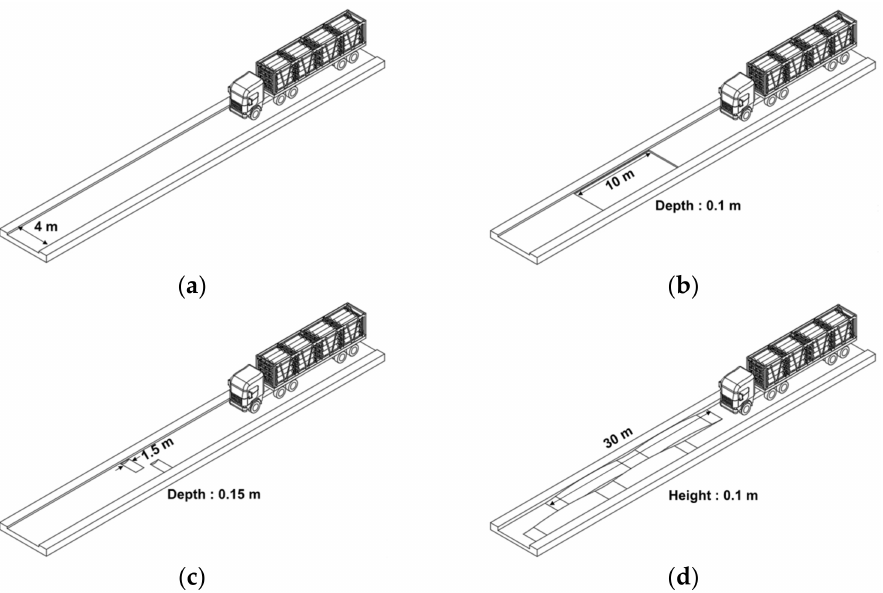
Figure 6. Shape by driving course. ( a ) Flat course; ( b ) pothole course; ( c ) short-wave course; ( d ) long- wave